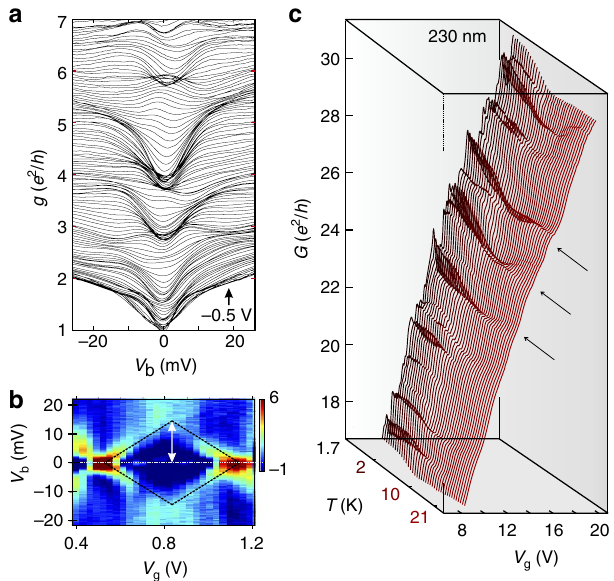
Figure 4 | Finite bias and temperature dependence of the quantized conductance. ( a ) Zero B -field differential conductance g as a function of bias voltage V b , measured at T ¼ 6K, taken at fixed values of back-gate voltage V g from (cid:3) 0.5 to 3.0V in steps of 30mV (see lower right label). The dense regions correspond to plateaus in conductance. ( b ) Transconductance q g / q V g in units of e 2 / h V (see colour scale) as a function of bias and back-gate voltage for a different cool-down of the same device (Supplementary Note 6). At V b ¼ 0, the transitions between conductance plateaus appear as red spots. At finite bias voltage, we observe a diamond-like shape, which provides an energy scale for the sub-band energy spacing D E E 13.5 ± 2meV (see dashed black lines and white arrow), which is also in good agreement with the energy scale observed in a (Supplementary Note 6). ( c ) Conductance traces as a function of temperature and back-gate voltage. We observe features with different temperature dependencies. Above around 10K only kinks related to quantized conductance survive (see